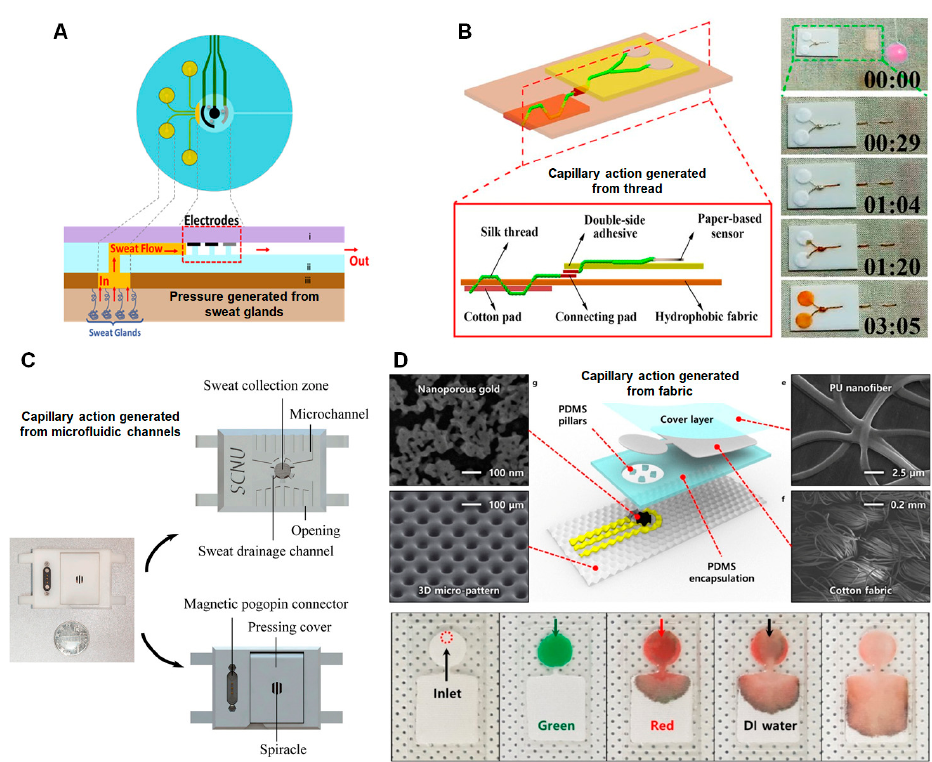
Figure 4. Epidermal wearable biosensors for passive sweat collection. Sweat collection through ( A ) pressure generated from sweat glands (Adapted with permission from Ref. [105]. Copyright 2017, American Chemical Society) and capillary action generated by ( B , D ) cotton thread or fabric (B is adapted with permission from Ref. [84]. Copyright 2020, Springer; D is reprinted with permission from Ref. [101]. Copyright 2019, American Chemical Society) or ( C ) microfluidic channels (Reprinted with permission from Ref. [106]. Copyright 2021, Elsevier).